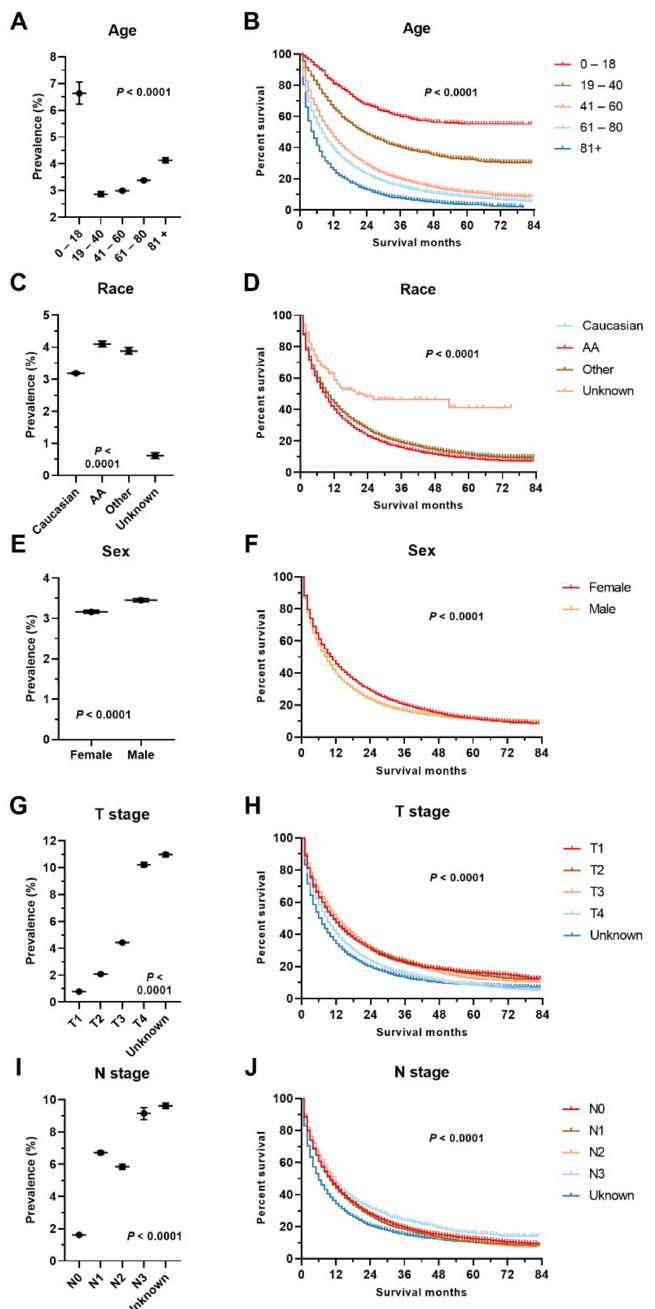
Figure 2. Disparities in prevalence and prognosis for sLM by age ( A , B ), race ( C , D ), sex ( E , F ), T stage ( G , H ), and N stage ( I , J ). Statistical tests were performed by Chi-square analyses and log-rank tests. Abbreviation: AA: African